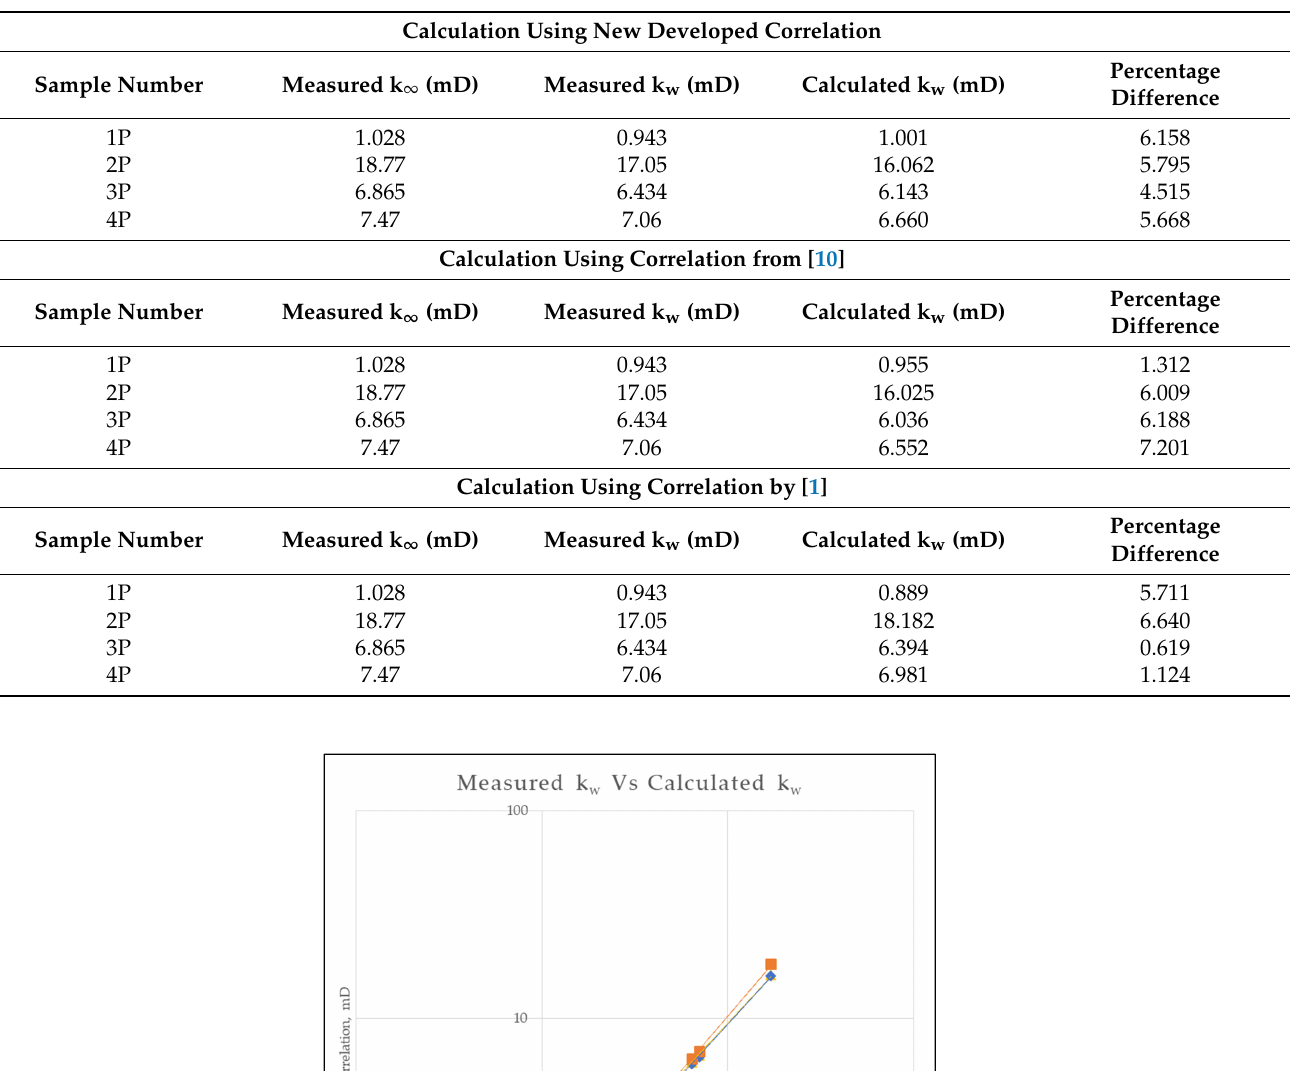
Table 8. Comparison between measured k w from published report and calculated k w from the new correlation, correlation from [10] and correlation from [1].